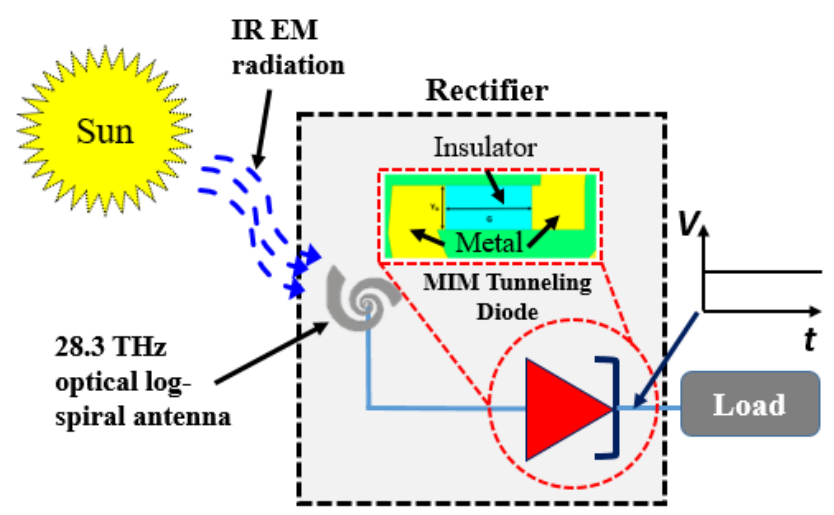
Figure 1. Infrared (IR) rectenna system for energy harvesting.